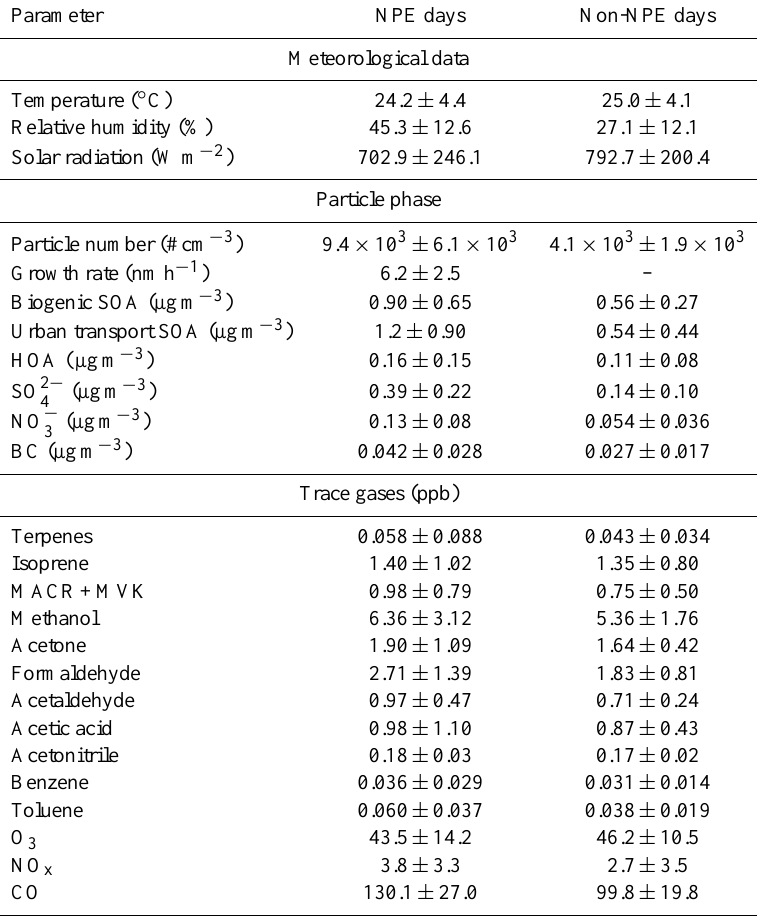
Table 2. Summary of average value ± 1 standard deviation for meteorological parameters, particle phase species, and gaseous species during new particle event (NPE) and non-NPE days at the T1 site between 08:00 and